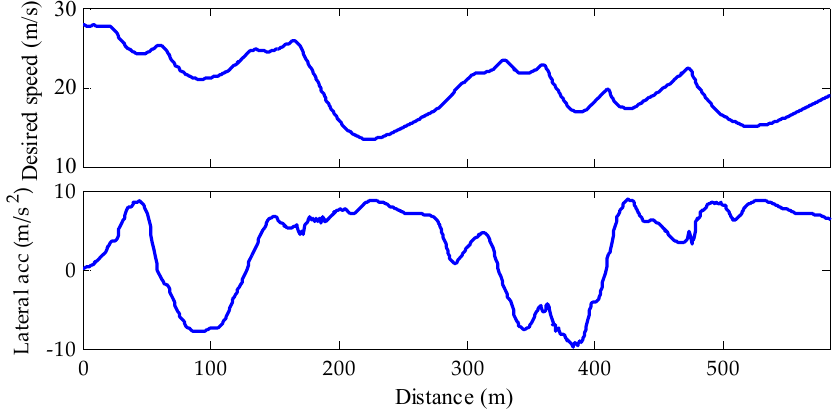
Figure 10. The desired speed and lateral acceleration.